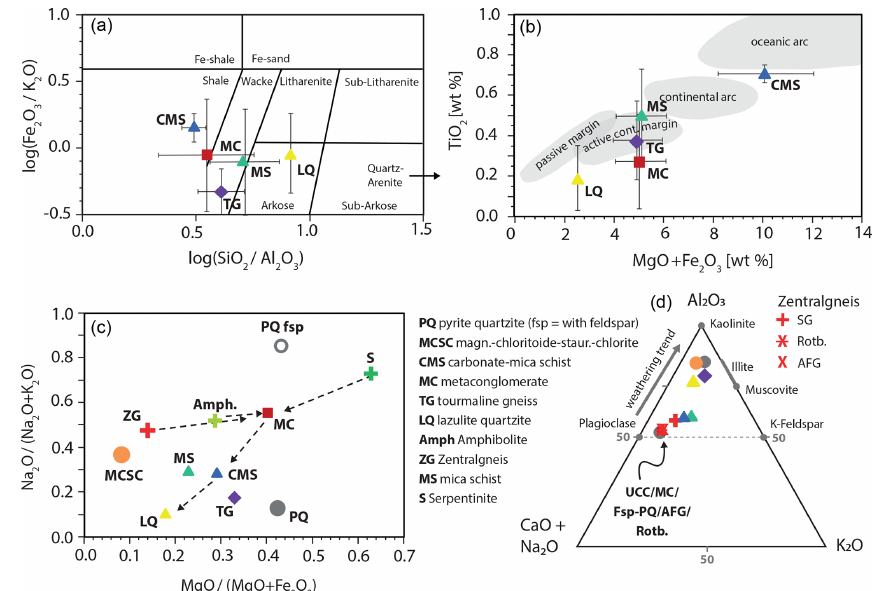
Figure 7. Chemical classification of metasedimentary units and from the Pfitsch–Mörchner basin its basement, using average compositions of the sample set (error bars indicate standard deviation). (a) Classification after Herron (1988); all units plot into the field of coarse- grained protoliths; only the carbonate–mica schist plots into the field of shale. (b) Geotectonic environment (Bhatia, 1983) using the mafic components and TiO 2 . The data plot close to the field for active continental margins; the low TiO 2 contents of lazulite quartzite and metacon- glomerate at a given MgO + Fe 2 O 3 are explained by dominance of the whole-rock composition by the Zentralgneis source; the high values of TiO 2 / MgO + Fe 2 O 3 for carbonate–mica schist indicate a higher input of heavy minerals associated with the higher amount of clay (cf. panel a ). (c) Average ratios of alkalies Na 2 O / (Na 2 + K 2 O) (Na#; wt%) and mafic components MgO / (MgO + Fe 2 O 3 ) (Mg#; wt%). The metaconglomerate can be explained as a mixture of Zentralgneis (ZG) with amphibolite (using the average composition of the latter as given by Dingeldey, 1992; Steffen and Selverstone, 2006) and serpentinite (dashed arrows). The mica schists and the tourmaline gneiss indicate increasing maturation of the fining-upwards series, and the lazulite quartzite has a well-sorted composition with the lowest Na# and Mg#. Pyrite quartzites (PQ) and the enclosed MCSC lenses represent only a small part of the source rocks. (d) Weathering index of different rock series (average molar values, not corrected for CO 3 ; weathering trend according to Nesbitt and Young, 1984). Metaconglomerate, two types of Zentralgneis (Augenflasergneis is AFG, and gneiss from the Rotbachlspitze is Rot), and feldspar-bearing pyrite quartzite plot at the composition of the upper continental crust (UCC) (Rudnick and Gao, 2003). The Schrammacher Gneis variety (SG) lies above the feldspar line, indicating that weathering/alteration of the original granitoid has already taken place. The pyrite quartzite and the MCSC lenses indicate strong